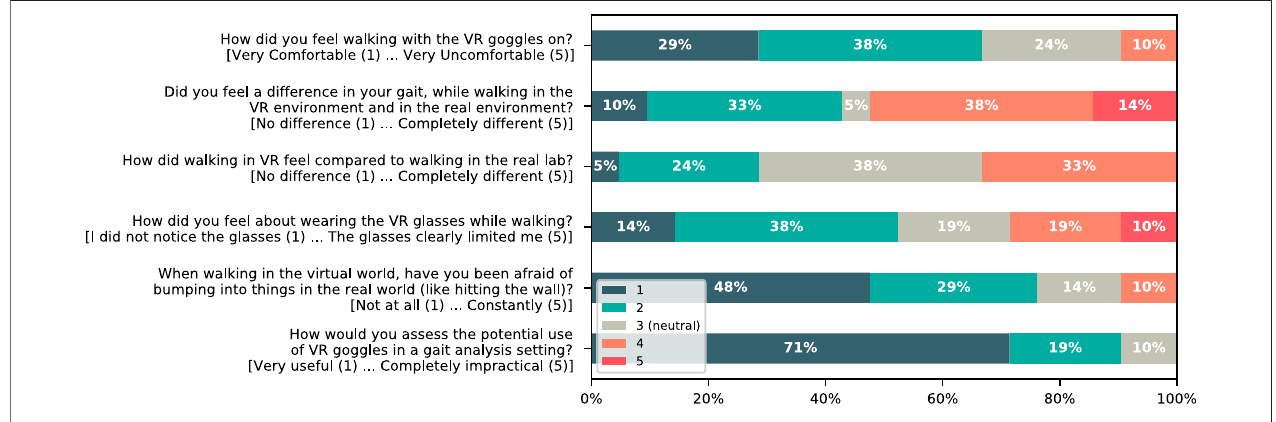
FIGURE 5 | Stacked bar graphs showing the percentage of participants reporting results of the six questions about how they perceived walking in the VR compared to the real-world. The extremes of the 5-point Likert scale are described in brackets next to each question on the y -axis.